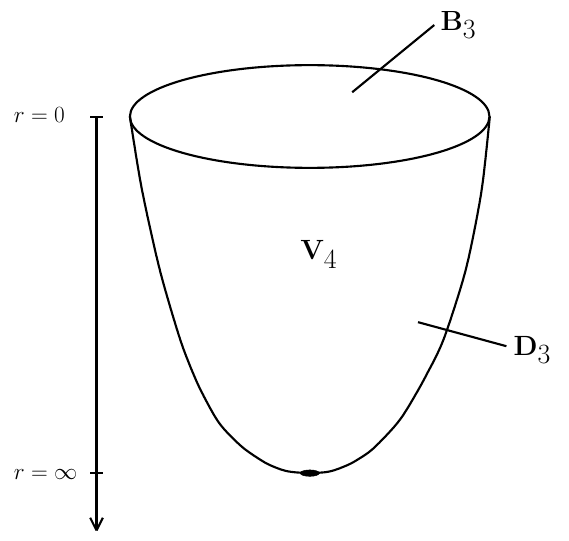
Figure 1 . Volume of integration V 4 for the baryon and its three-dimensional boundaries B 3 + D 3